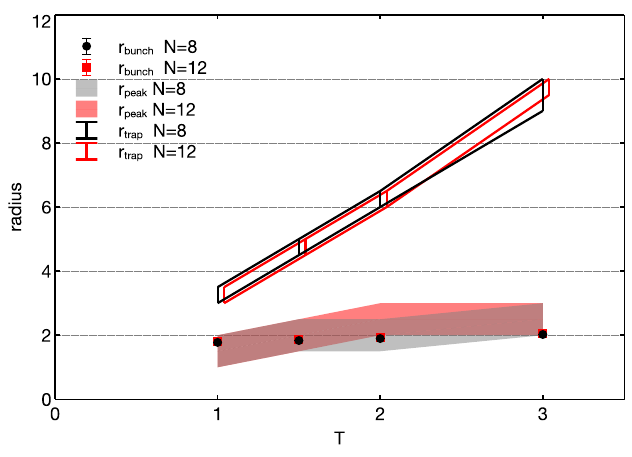
Figure 4 . Plot of r bunch , r peak and r trap for L = 10 and two values of N . The r trap results for di(cid:11)erent N values are horizontally displaced for clarity. The values of r peak and r trap are only determined as intervals between di(cid:11)erent simulated values of r 0 : the former is determined by the interval containing the three largest values of the force, while the latter is determined by subsequent values of r 0 where the force changes sign from positive to